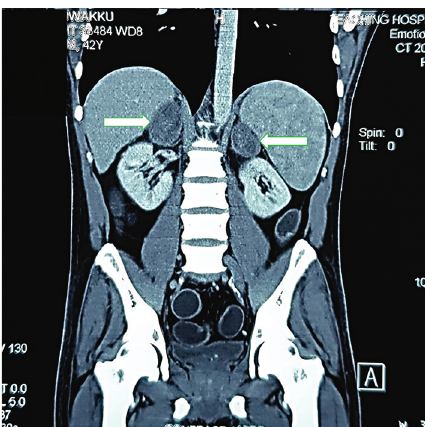
Figure 1: CECTabdomen showing bilateral adrenal masses (white